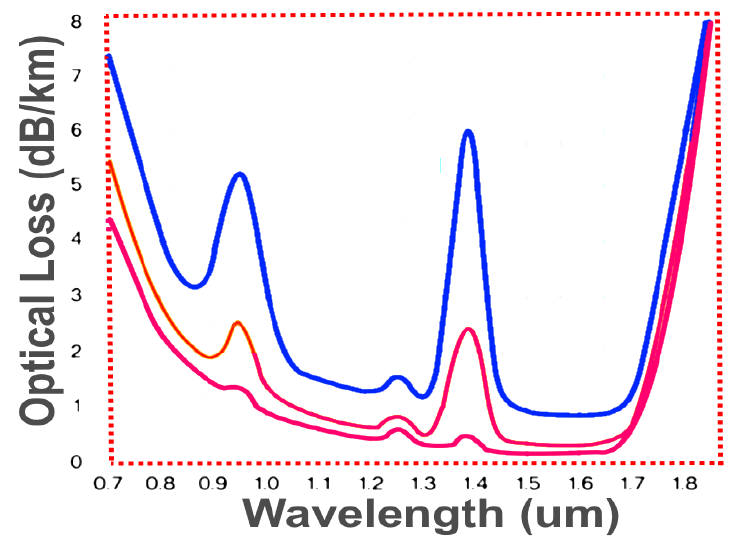
Figure 4. Attenuation against wavelength transmission windows.